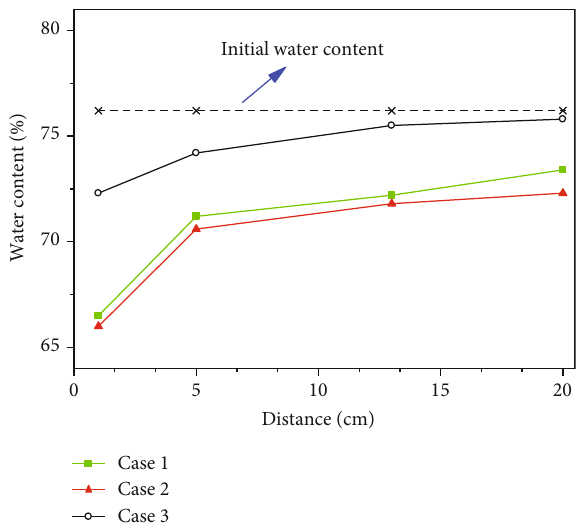
Figure 12: Radial moisture content distribution